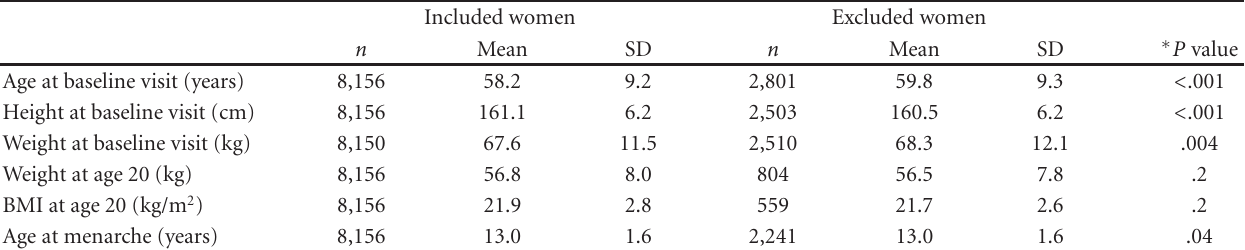
Table 1: Characteristics of EPIC-Norfolk women included in the current study.